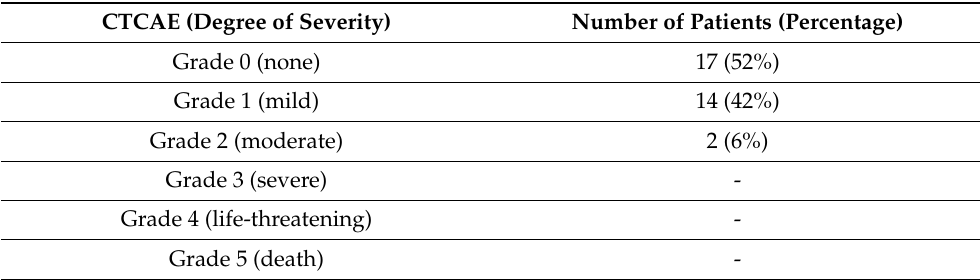
Table 6. Characteristics of the early toxicity of radiotherapy and the brachytherapy procedure. CTCAE—Common Terminology Criteria for Adverse Events.